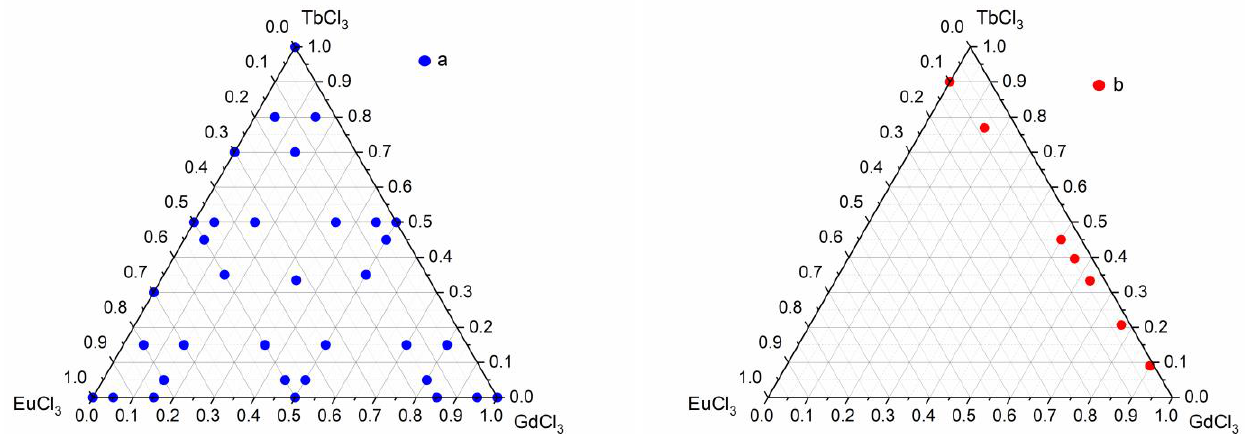
Figure 10. Ratios of REE chlorides (Gd, Eu and Tb) chosen (points a ) for the synthesis of layered rare earth basic chlorides (Gd 1 − x − y Eu x Tb y ) 2 (OH) 5 Cl · n H 2 O and (points b ) for the synthesis of layered rare earth basic sulfobenzoates (Gd 1 − x Tb 0.9 x Eu 0.1 x ) 3 (OH) 7 (C 7 H 4 O 5 S) · H 2 O.